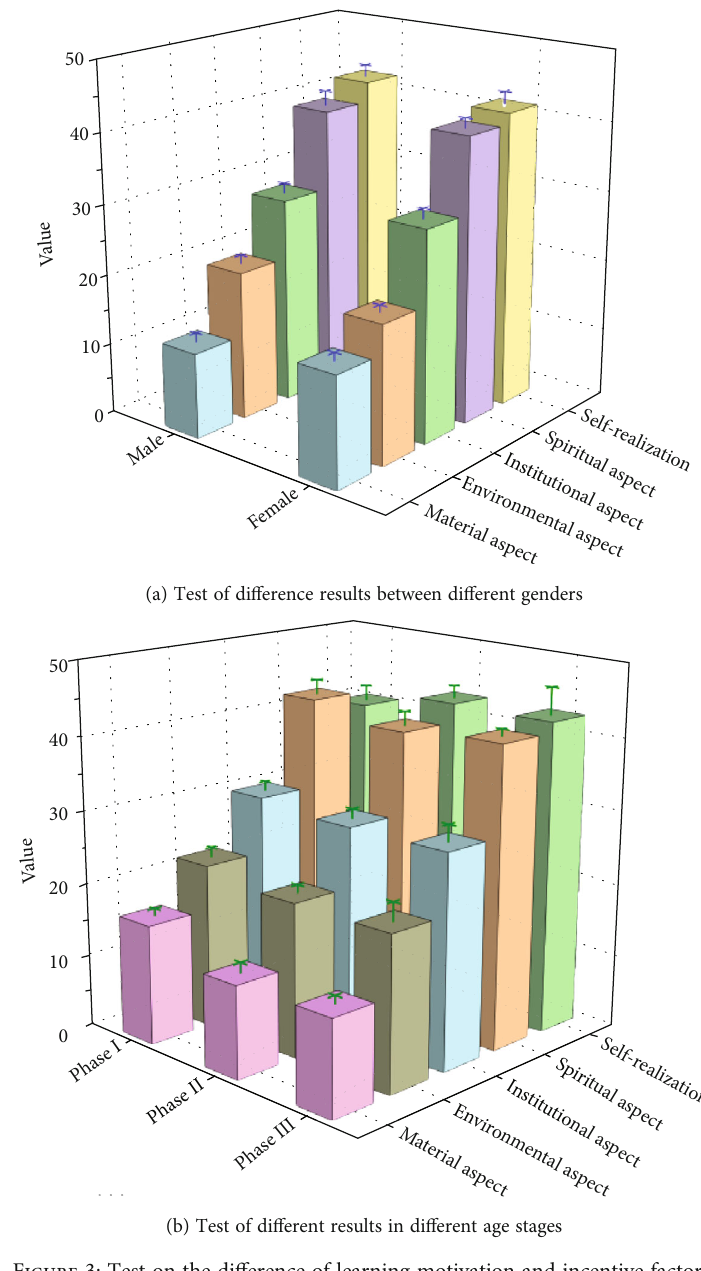
Figure 3: Test on the di ff erence of learning motivation and incentive